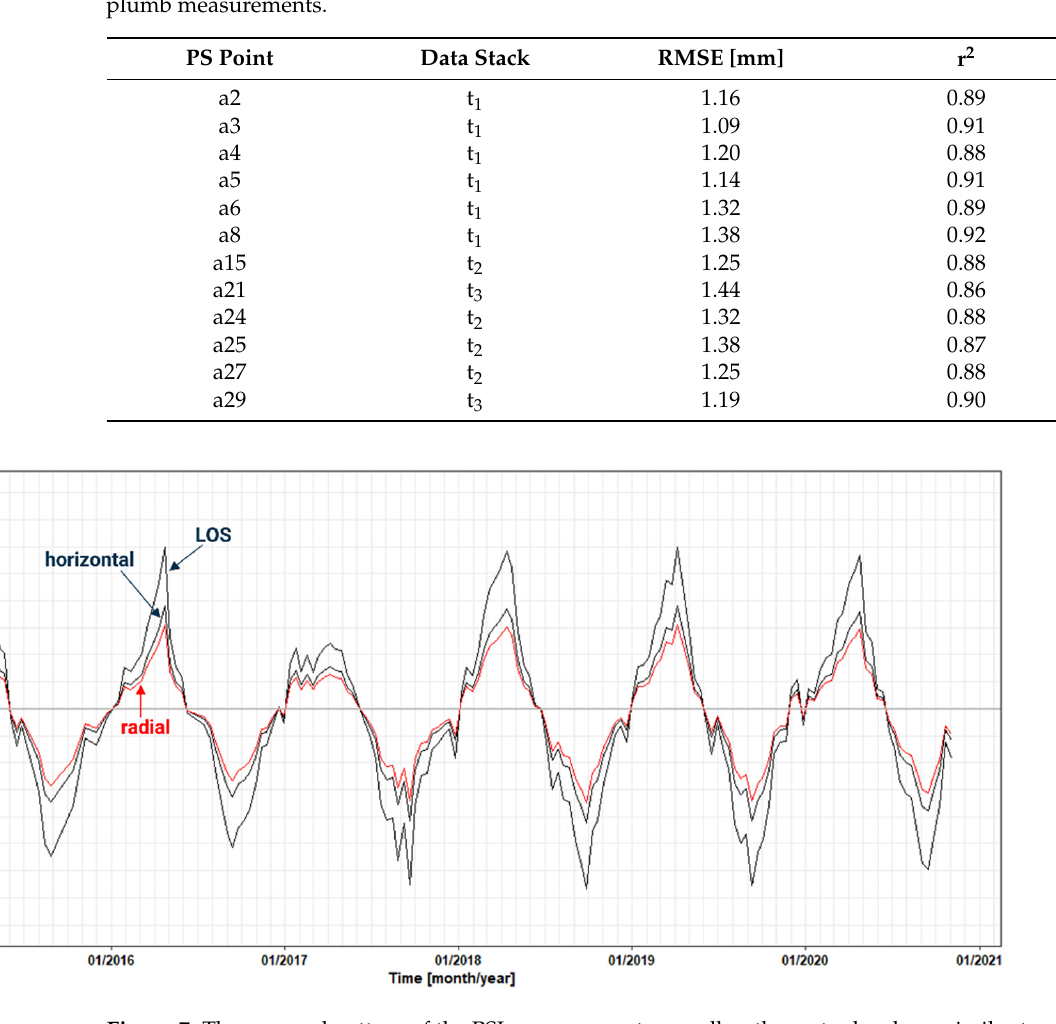
Figure 8. Comparison between PSI measurements and the water level of the Moehne lake. Seasonal patterns are similar to each other, and the connection between the two measurements is visible. In the following section, results of the accuracy analyses using the radial defor- mations are presented. 3.3. Accuracy Analysis The radial deformations were visually and statistically compared with the in situ measurements. Figure 9 illustrates the annual deformation rates for three single PS points, one out of each data stack, respectively. Additionally, plumb measurements and trigono- metric measurements of the nearest measuring point are included. Since plumb measure- ments resolution is on a daily basis, the seasonal cycle can be tracked very simply.